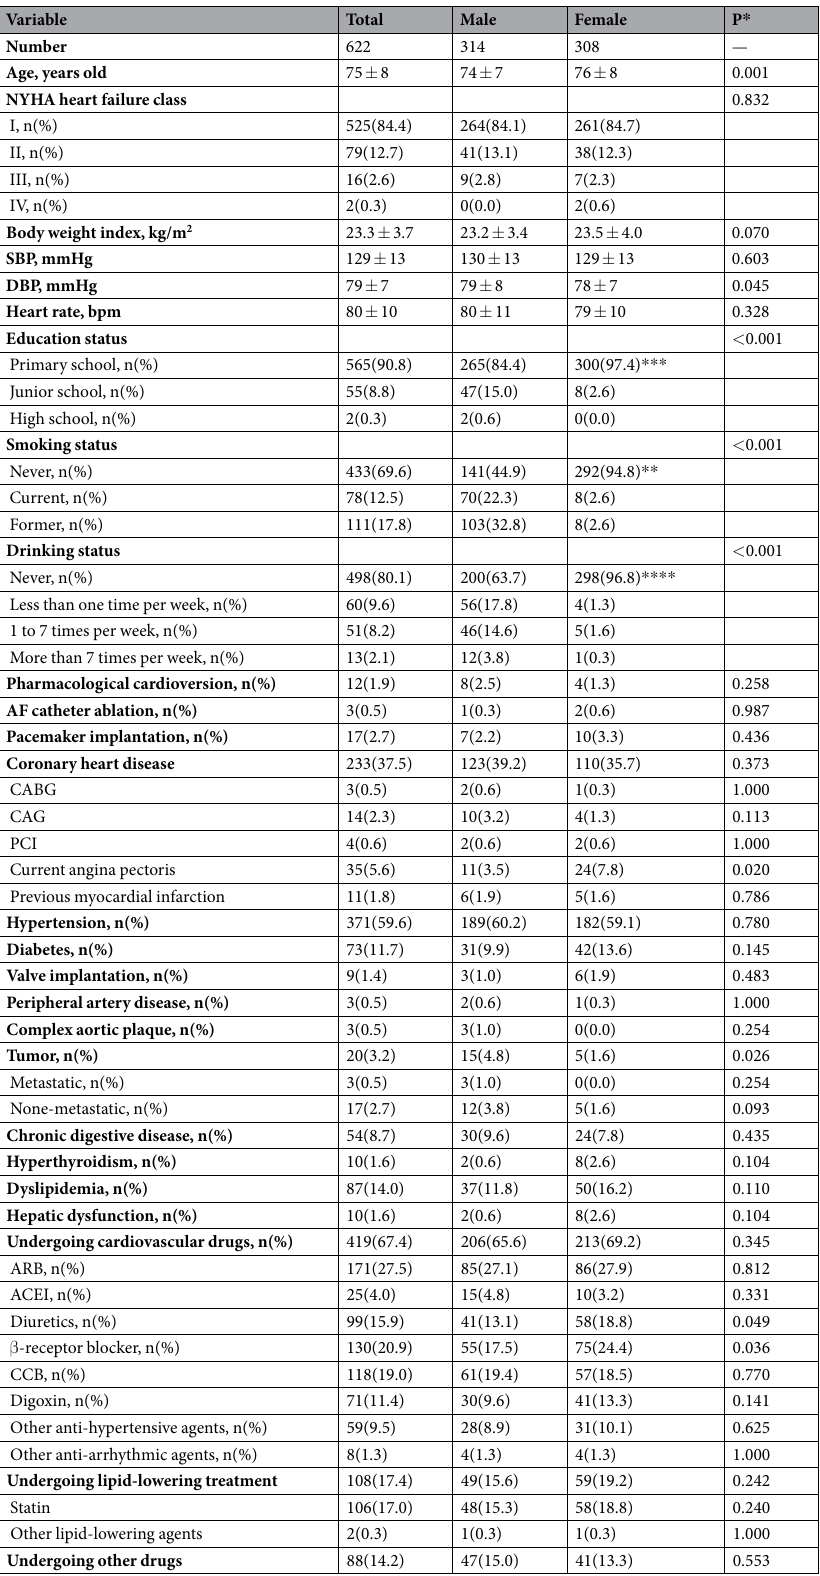
Table 2. Clinical characteristics of patients with atrial fibrillation. NYHA, New York Heart Association; SBP, systolic blood pressure; DBP, diastolic blood pressure; AF, atrial fibrillation; CABG, coronary artery bypass grafting; CAG, coronary angiography; PCI, percutaneous coronary intervention; ARB, angiotensin receptor blocker; ACEI, angiotensin converting enzyme inhibitor; CCB, calcium channel blocker. * P values for comparing the males with the